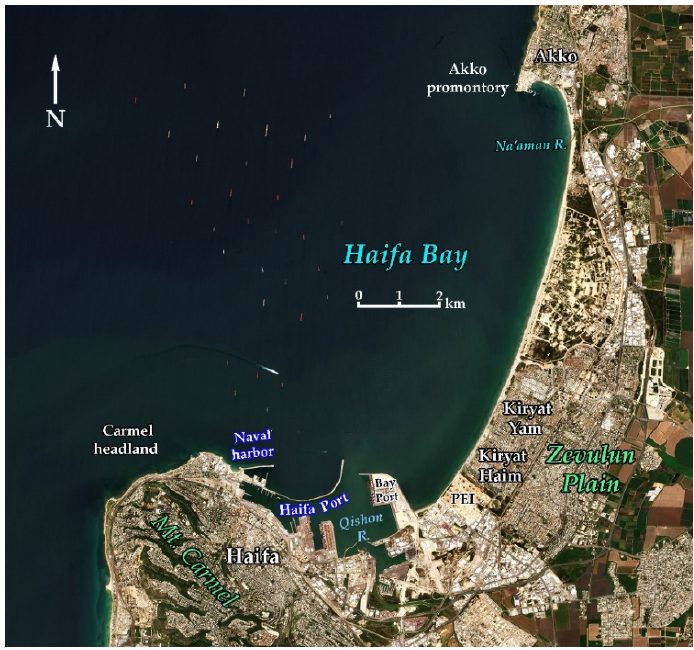
Figure 2. Haifa Bay area. Background: part of Sentinel-2 L2A, True color imagery,365XB https://www.sentinel-hub.com (accessed on 15 April 2021).